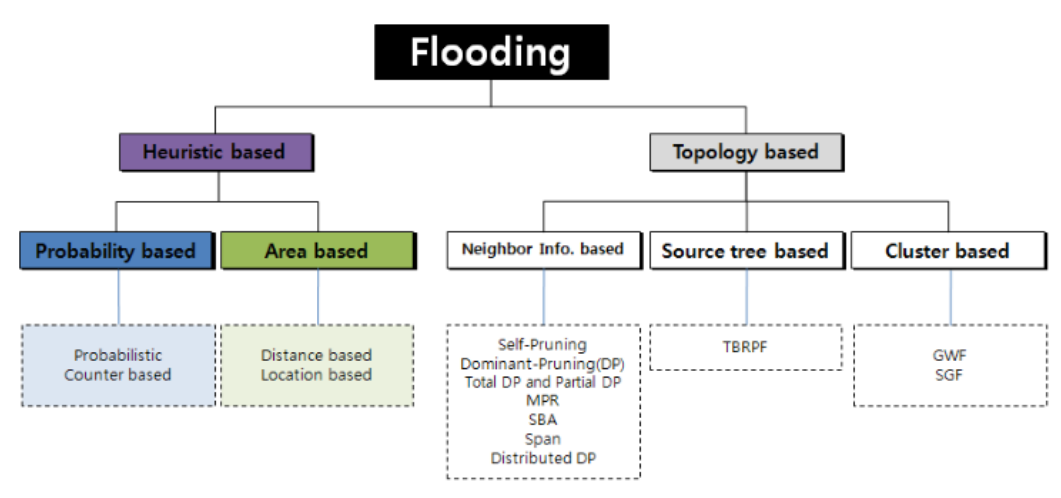
Figure 2. Taxonomy of flooding